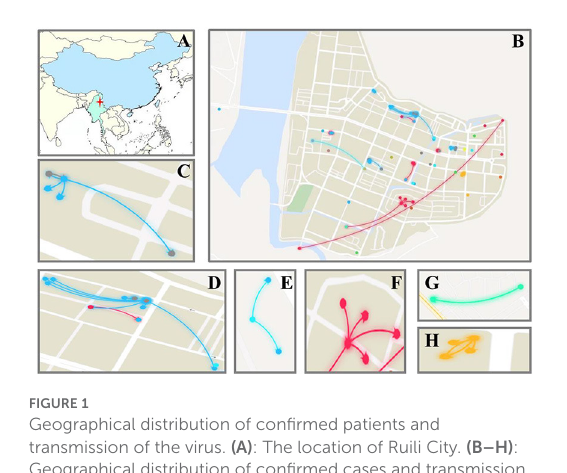
FIGURE1 Geographical distribution of confirmed patients and transmission of the virus. (A) : The location of Ruili City. (B–H) : Geographical distribution of confirmed cases and transmission chains; the lines mean the virus transmission caused by close contacts; different colors of lines means different transmission